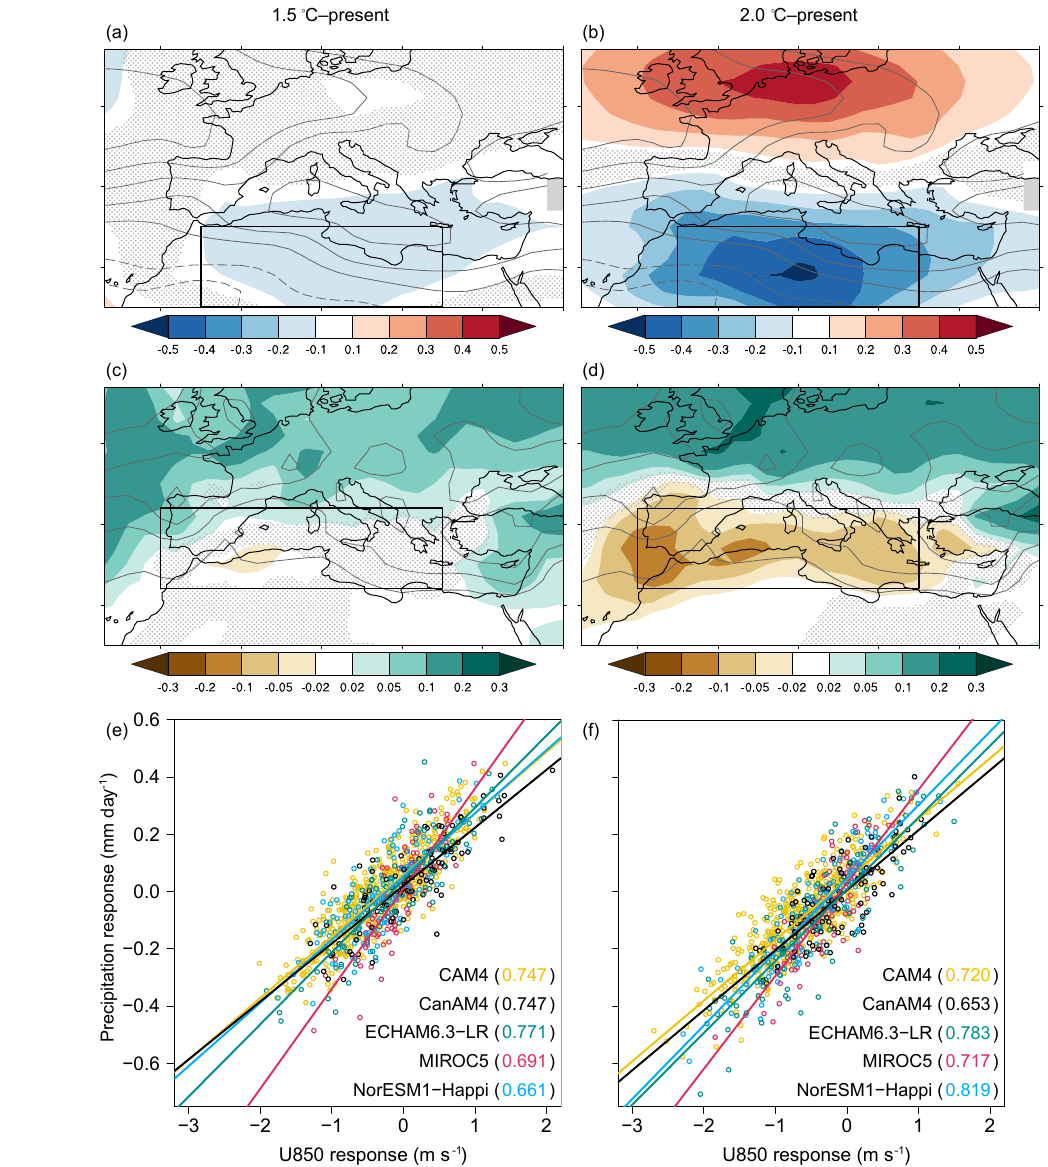
Figure 12. Multi-model mean winter (DJF) response of (a–b) zonal wind at 850hPa and (c–d) precipitation in the 1.5 ◦ C (a, c, e) and 2.0 ◦ C (b, d, f) experiments relative to PD. Panels (a) and (b) show the multi-model mean responses (shading) and the PD climatology (contour interval 2ms − 1 ; dashed contours for negative values; zero contour omitted) for u 850. Panels (c) and (d) show the multi-model mean responses (shading) and the PD climatology (contour interval 1mmd − 1 ) for precipitation. Stippling in (a) to (d) masks out regions where the response is very weak (signal-to-noise ratio | β/σ | < 0 . 1). Panels (e) and (f) show the relationship between the area-averaged precipitation and u 850 responses in the (e) 1.5 ◦ C and (f) 2.0 ◦ C experiments relative to PD, with the R 2 value for each model indicated in the legend. Boxes in the maps indicate the regions used for calculating area-averaged